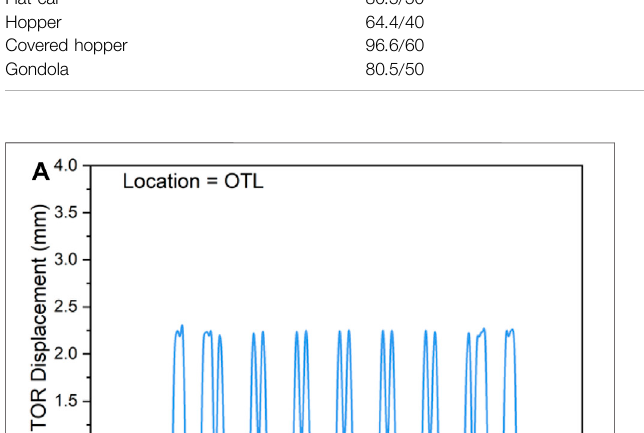
Frontiers in Built Environment |